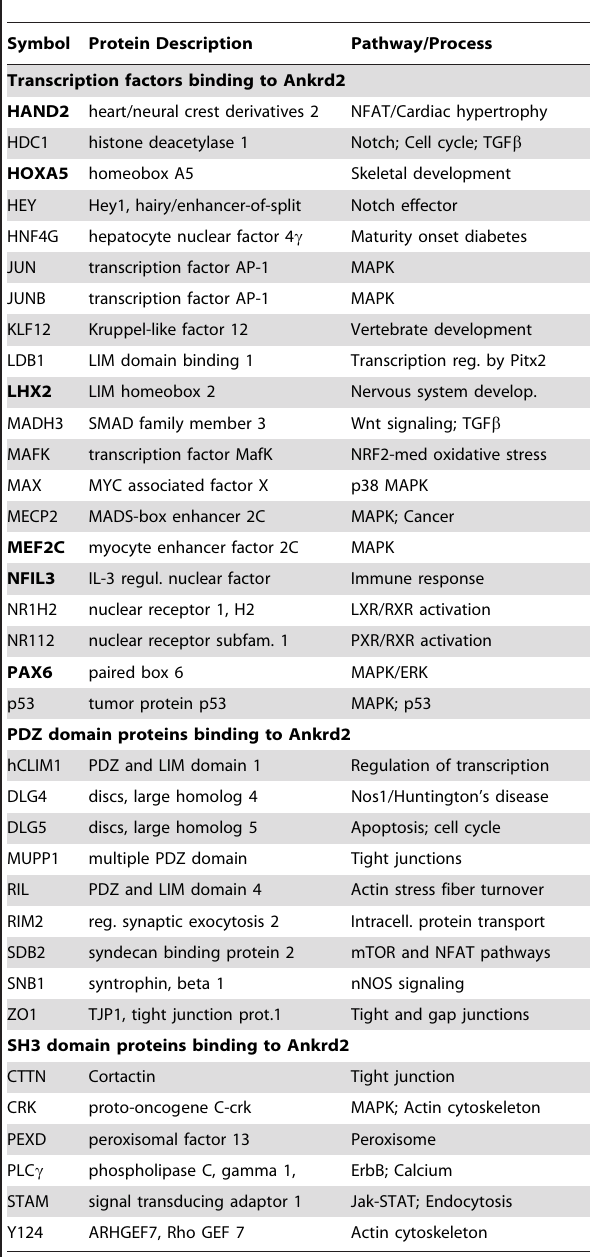
Table 2. Ankrd2 protein interactions detected by protein-